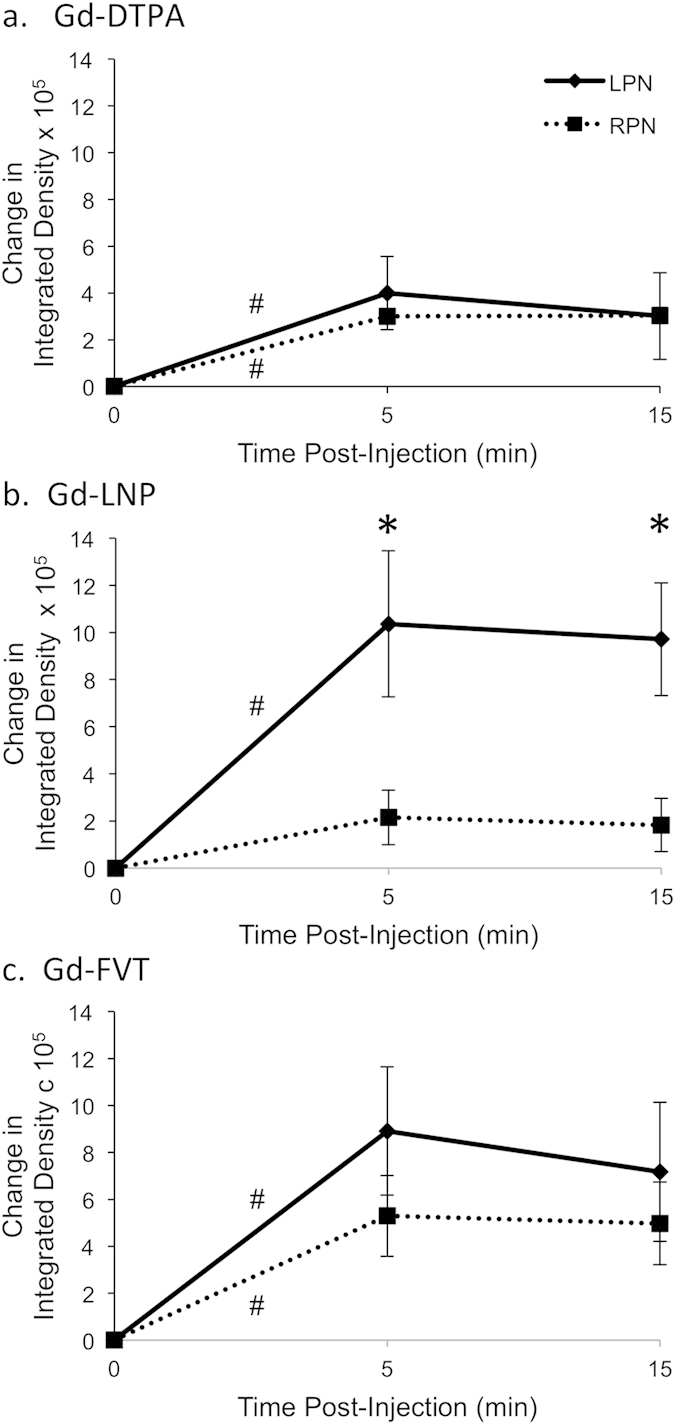
Quantitation of contrast agent uptake in tumor-draining and uninvolved popliteal lymph nodes.Integrated density values over each popliteal LN were calculated using the 90th percentile threshold method. Change from pre-contrast integrated density is summarized for groups of 6 mice receiving each contrast agent, with standard error bars displayed at each timepoint. (a) The integrated density of Gd-DTPA contrast uptake into ROIs increases within 5 min after injection in the LPN (#p = 0.01) and RPN (#p = 0.006), as estimated in a linear mixed effects regression model. (b) The integrated density of Gd-LNP contrast uptake increases within 5 min after injection for the tumor-draining LPN (#p = 0.009), but not for the RPN (p = 0.24). Moreover, the contrast uptake into the LPN is significantly higher than into the RPN at both 5 and 15 min after injection (*p < 0.01). (c) Gd-FVT uptake into the LPN and RPN 5 min after injection is statistically significant (#p = 0.02 for both), although the difference in contrast uptake between the LPN and RPN is not significantly different at 5 min (p = 0.14) or 15 min (p = 0.52).